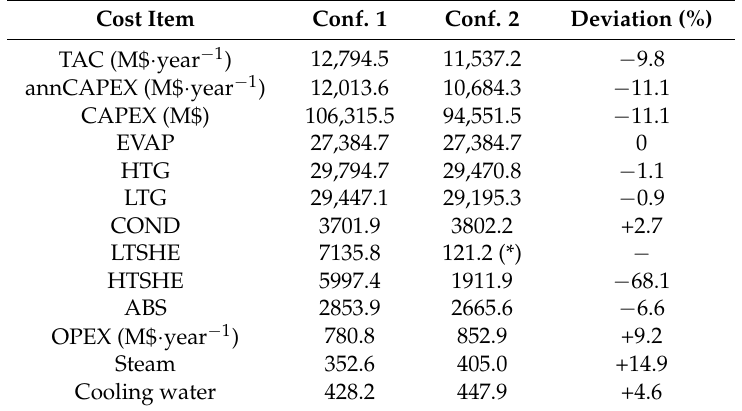
Table 1. Optimal costs obtained for configurations Conf. 1 and Conf. 2 for a cooling capacity of 16 kW.